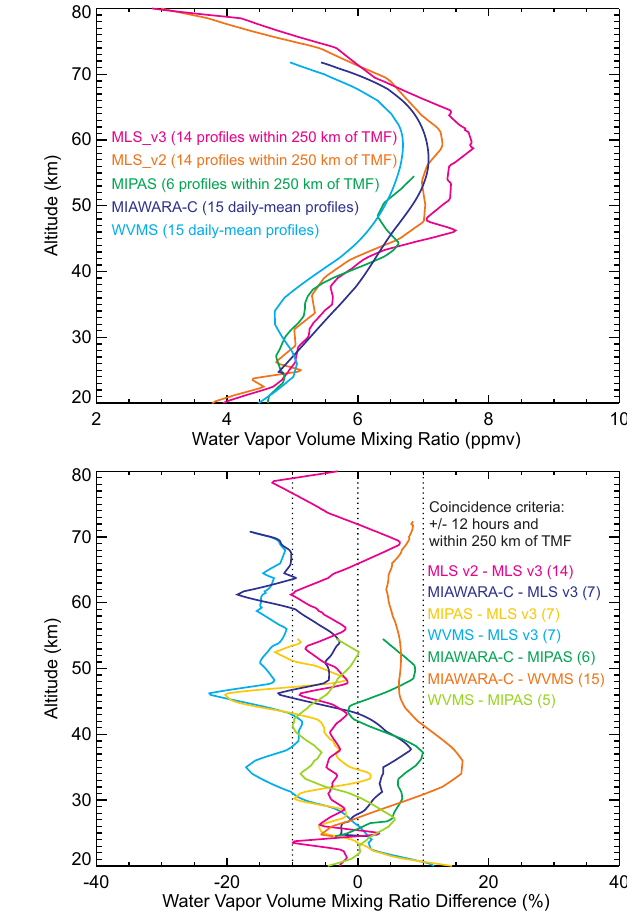
Fig. 11. Water vapor mixing ratio profiles measured simultaneously by Aura-MLS v2, v3, and CFH during MOHAVE-2009 (top), and their relative difference (bottom).